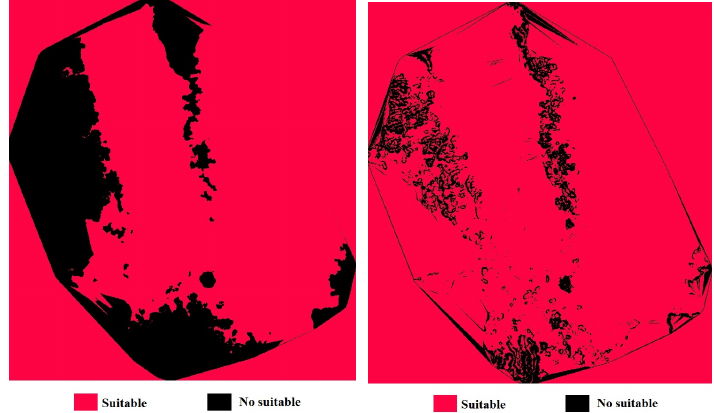
Figure 3. Suitability parameters: ( left ) Red Cells are suitable elevations for urban development, and Black Cells are elevations not suitable for urban development; and ( right ) Red Cells are slopes suitable for urban development, and Black Cells are slopes not suitable for urban development .